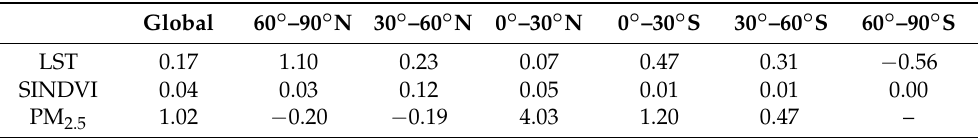
Table 1. Changes of LST, SINDVI, and PM 2.5 at different latitudinal bands from 2001 to